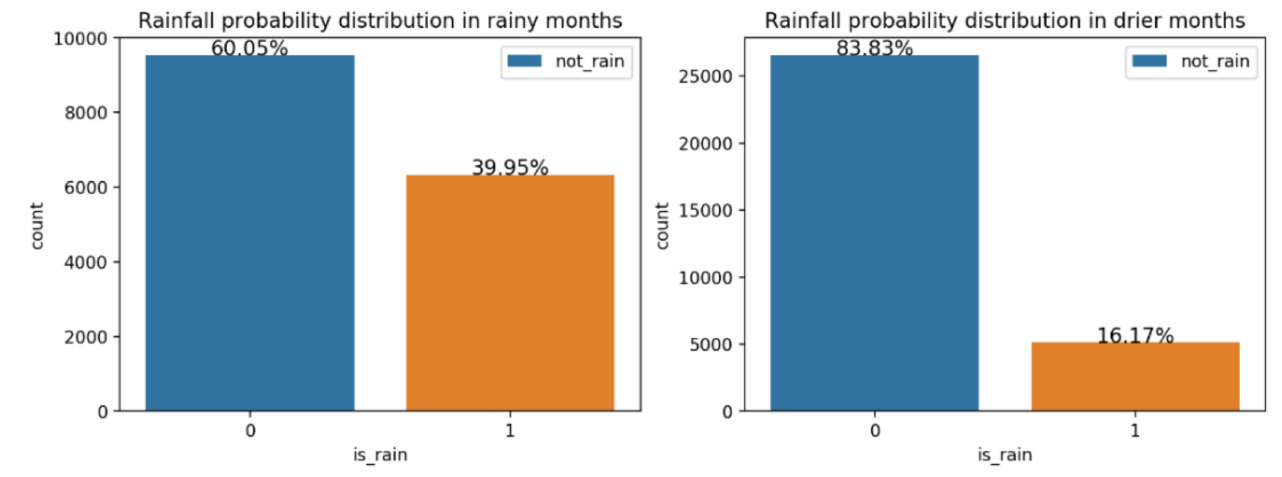
Figure 2. Rainfall probability distribution.